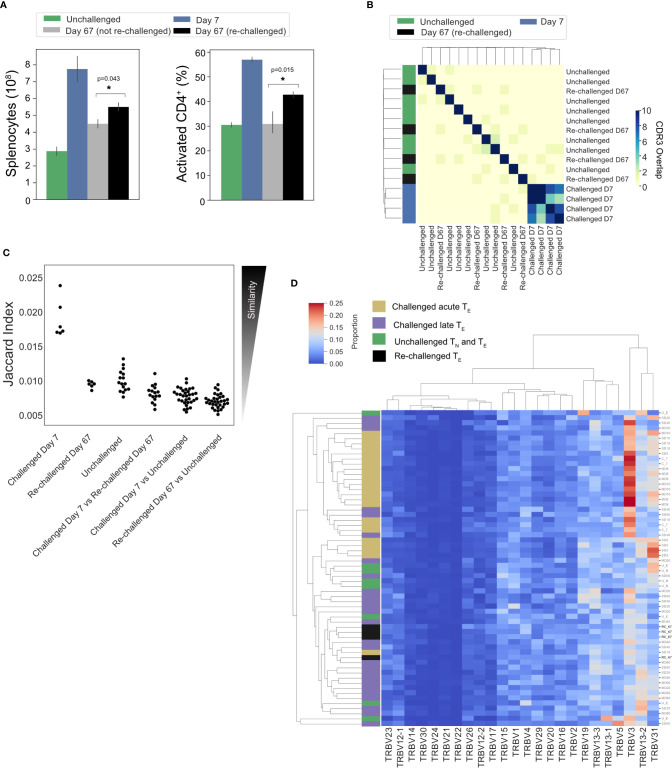
No conservation of response following homologous re-challenge: (A) Splenocyte numbers and frequency of activated CD4+T cells (CD44HI) of unchallenged mice (green), day 7 post-primary infection (blue), day 67 post primary infection (gray, not re-challenged) and 7 days following re-challenge (black, re-challenged day 67). (B) Clustermap depicts the pairwise overlap of the top 100 most abundant CDR3 amino acid sequences of repertoires from the re-challenge experiment. The size of the pairwise intersection between each repertoire (number of shared CDR3 amino acid sequences) is displayed. CDR3 overlap was calculated unweighted by clonotype frequency. (C) Jaccard (similarity) index of replicate repertoires (normalized by down-sampling to 5000 UMI) and (D) Clustermap displays the TRBV gene proportion of each repertoire for challenged acute TE repertoires (gold), challenged late phase TE repertoires (purple) and unchallenged TN and TE repertoires (green) from the first experiment, with re-challenged TE repertoires (black) also included.